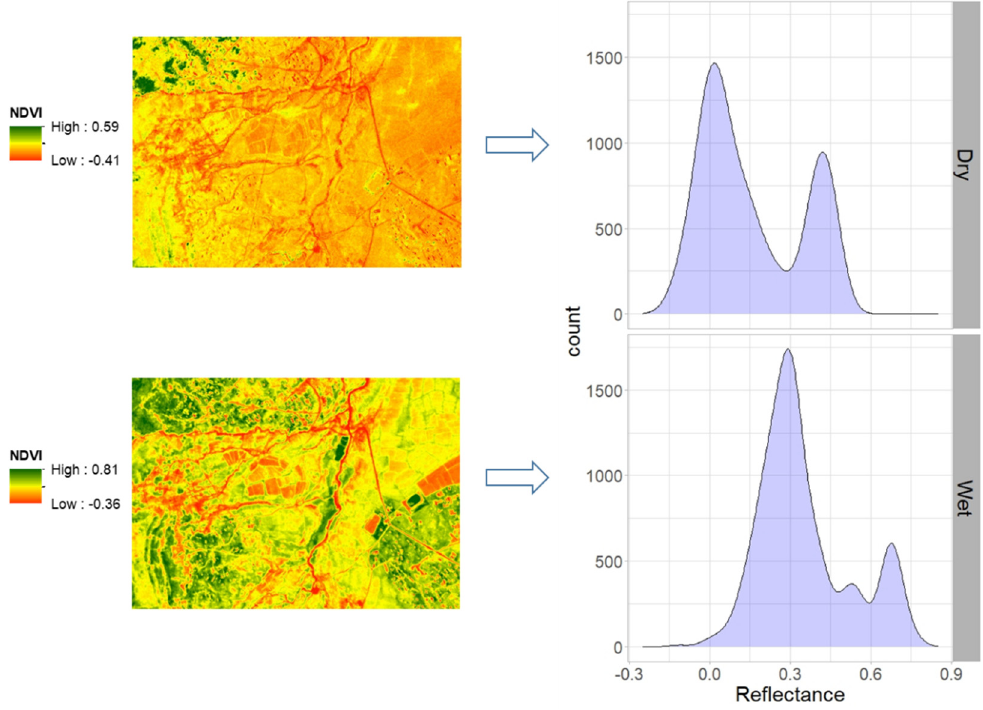
Figure 3. Distribution of NDVI reflectance values in the dry and wet season.